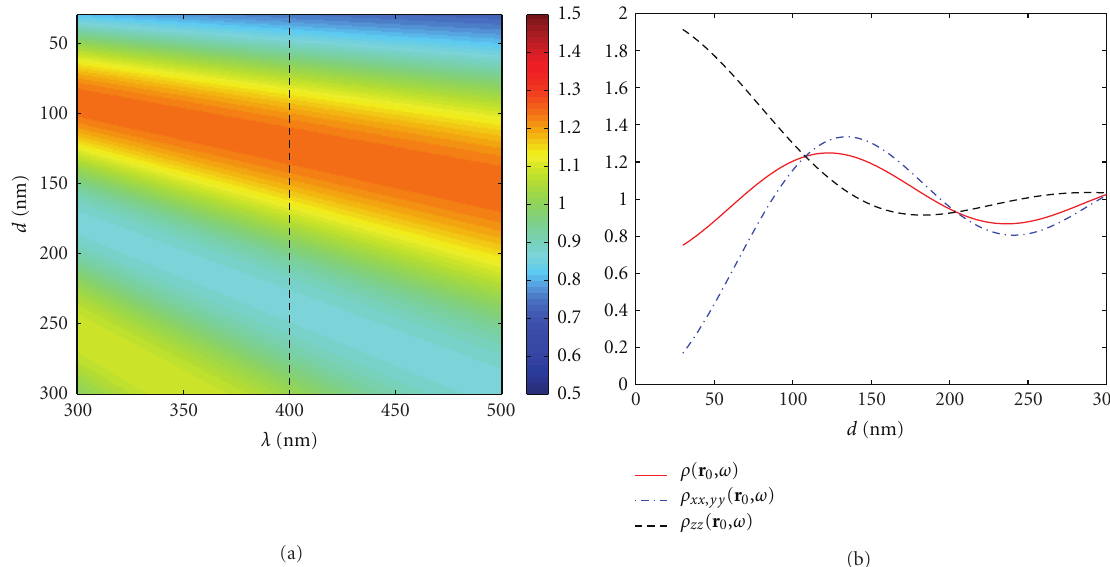
Figure 3: (a) map of the normalized LDOS ρ ( r 0 , ω ) /ρ vac ( ω ), with ρ ( r 0 , ω ) = 2 ω / ( πc 2 )Im[Tr G reg ( r 0 , r 0 , ω )] and ρ vac ( ω ) the LDOS in vacuum, versus both the wavelength λ and the distance d between the mirror and the center of the nanoparticle. The vertical dashed line is a guide to precise the wavelength at which panel (b) has been plotted. (b) distance dependence of the LDOS (red solid line) and of the partial LDOS (blue and black dashed lines) defined by ρ ii ( r 0 , ω ) = 2 ω / ( πc 2 )Im[ G reg, ii ( r 0 , r 0 , ω )] with i = x , y , z for λ = 400nm. The partial LDOS ρ ii ( r 0 , ω ) drives the dynamics of a dipole oriented along direction i , while the LDOS sums up the contributions of the three orientations. Due to symmetry in the geometry in Figure 2, the partial LDOS along x and y is equal. In all calculations, the minimum distance d (cid:7) 2 R has been chosen at the limit of validity of the dipole approximation